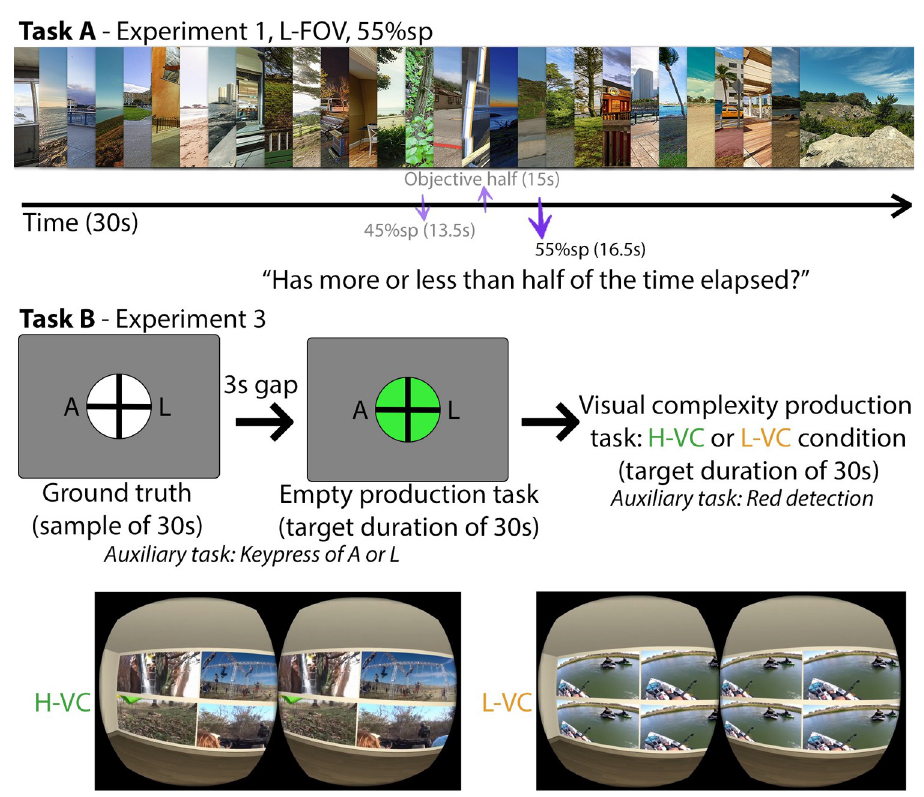
Fig 1. Illustration of the experiments flow. Task A ) Binary task used in Experiments 1–2 . Illustrative example for a single trial (L-FOV condition in Experiment 1 at the 55% sp, see Section 2.1). During a trial, participants indicated whether “more than half” or “less than half” of the duration had passed, at a temporal sampling point that was 55% of the total duration (16.5s). Task B ) The double production task used in Experiment 3 . First participants were presented with an empty scene for 30s ( ground truth ) while performing an auxiliary task (detecting the presence of A or L on screen with a corresponding keypress). Then they were asked to press a key after 30s had elapsed ( empty production task ). At this point, the empty scene was replaced with a scene in the H-VC or L-VC condition (high or low visual complexity, respectively). After the change of scene, participants had to press a key when 30 more seconds had elapsed ( visual complexity production task ). In the H-VC condition, the four screens of the virtual room displayed different videos at the same time. In the L-VC condition, the four screens presented the same video synchronously.